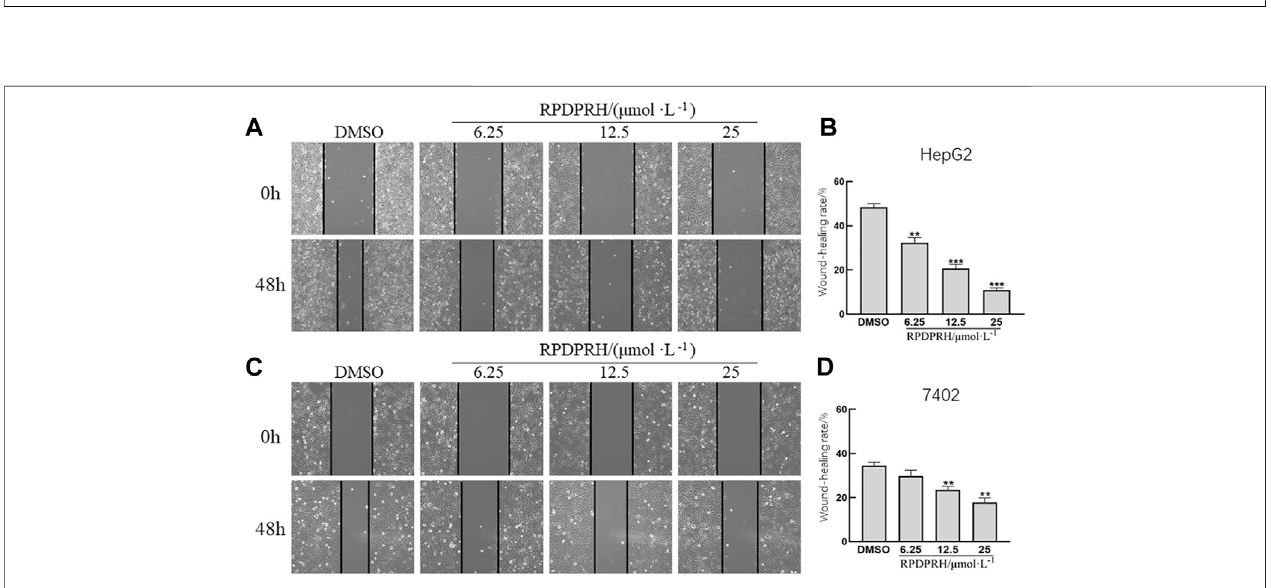
FIGURE 2 | Effect of RPDPRH on the expressions of Bax and Bcl-2. Note: (A) Protein expression bands of Bcl-2 and Bax in HepG2 cells. (B) Relative protein expressionsofBcl-2andBaxinHepG2cells. (C) ProteinexpressionbandsofBcl-2andBaxin7402cells. (D) RelativeproteinexpressionsofBcl-2andBaxin7402cells. Compared with the DMSO control group, * p < 0.05 and ** p < 0.01, ( ‾ x ± s, n=3).